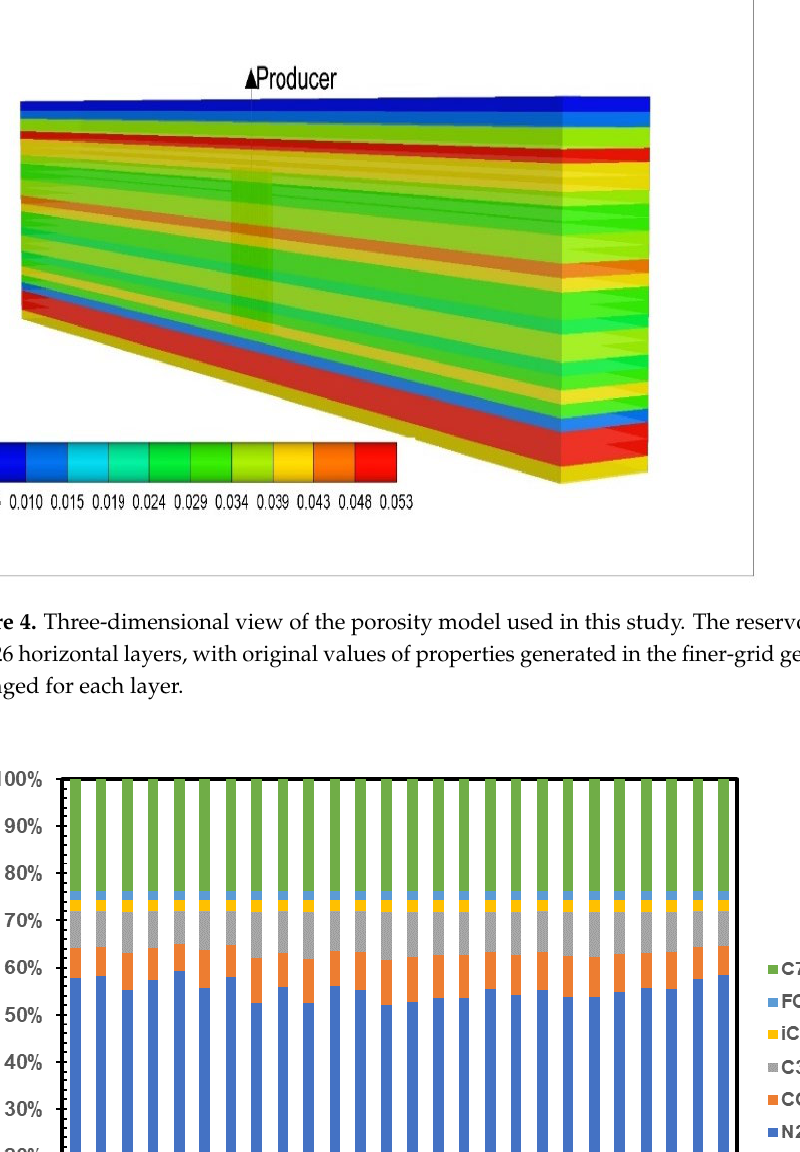
Table 1. Various model input values.